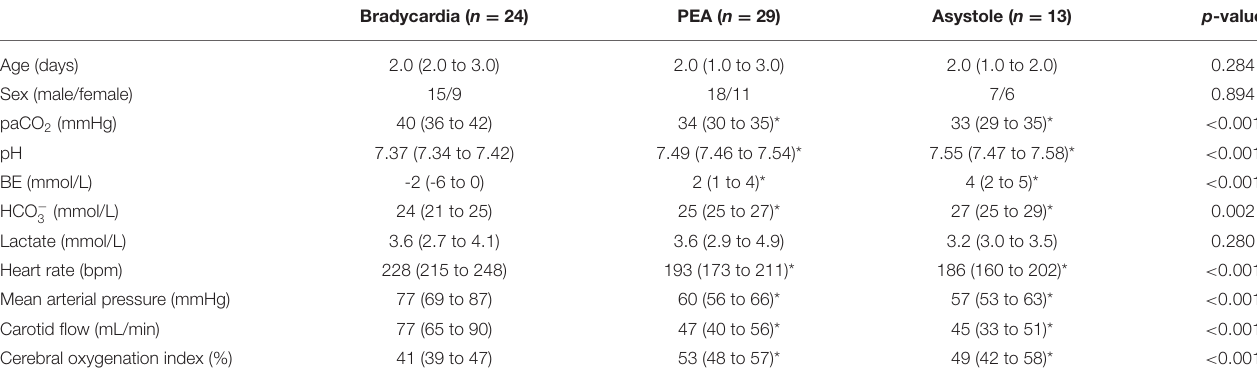
TABLE 1 | Baseline